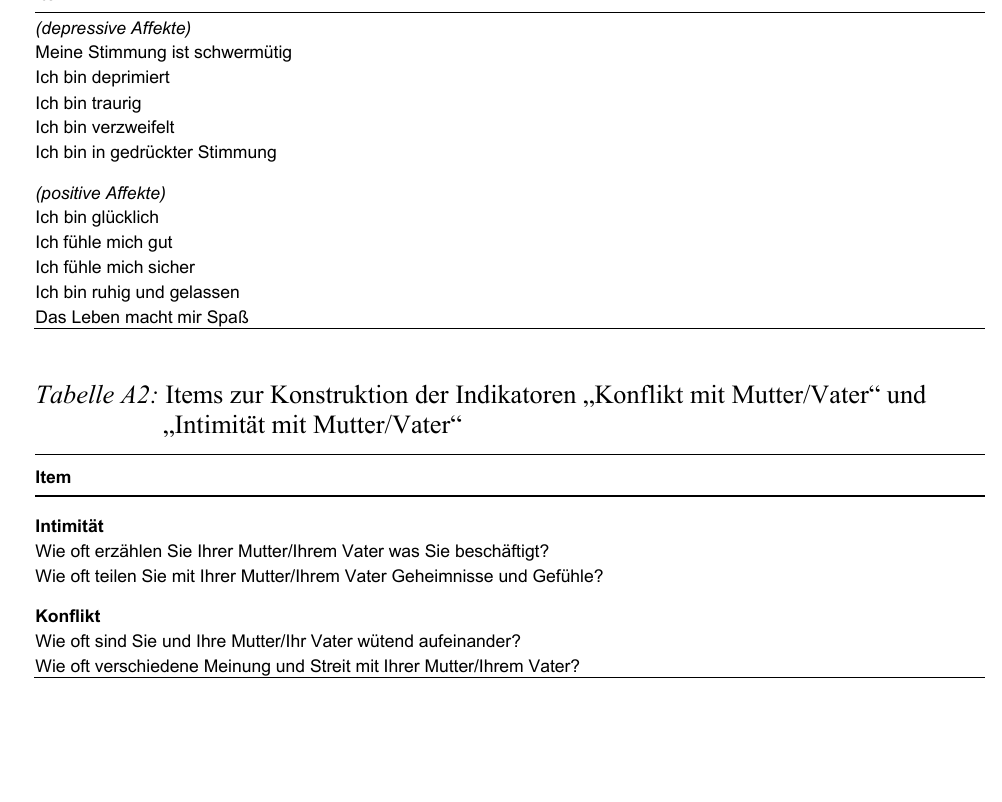
Tabelle A1: Items zur Konstruktion des Indikators für die „Depressivität“ Item